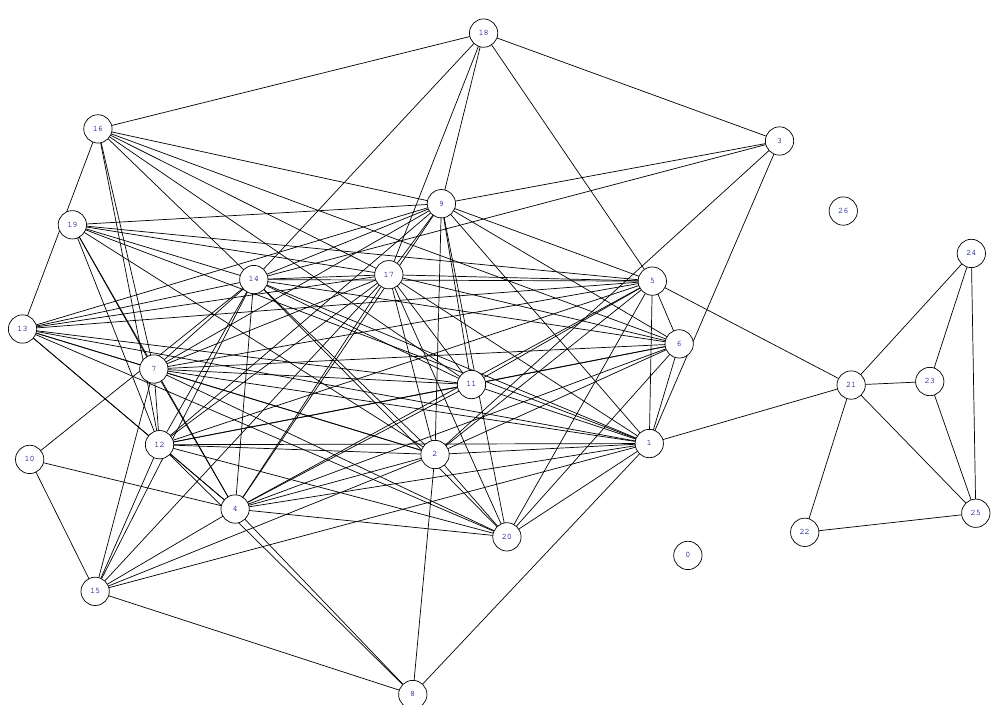
Figure 3. Self-reported friendship graph from the nodes participating in the Sassy